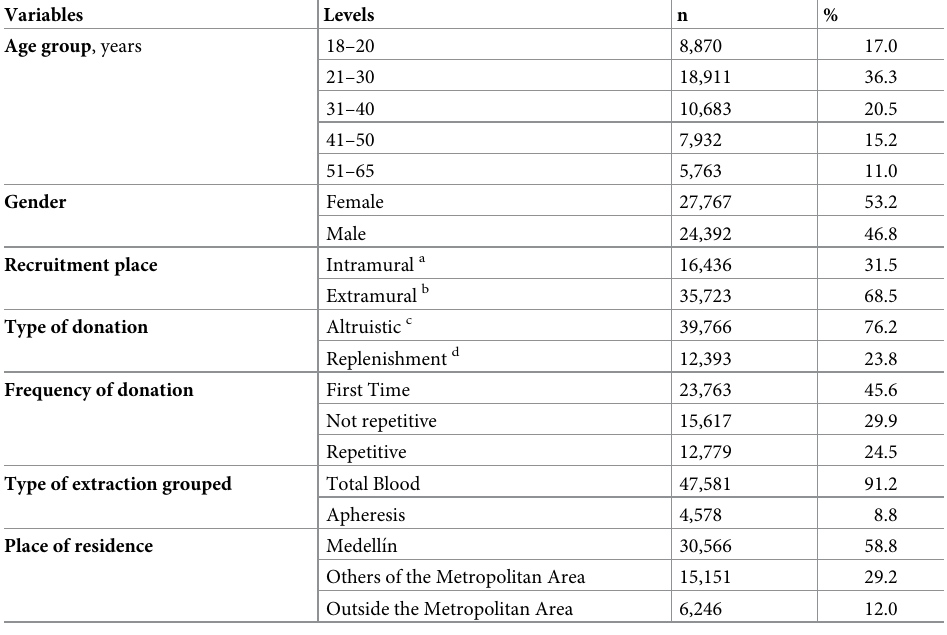
Table 1. Demographic description and some characteristics related to donation in the study.